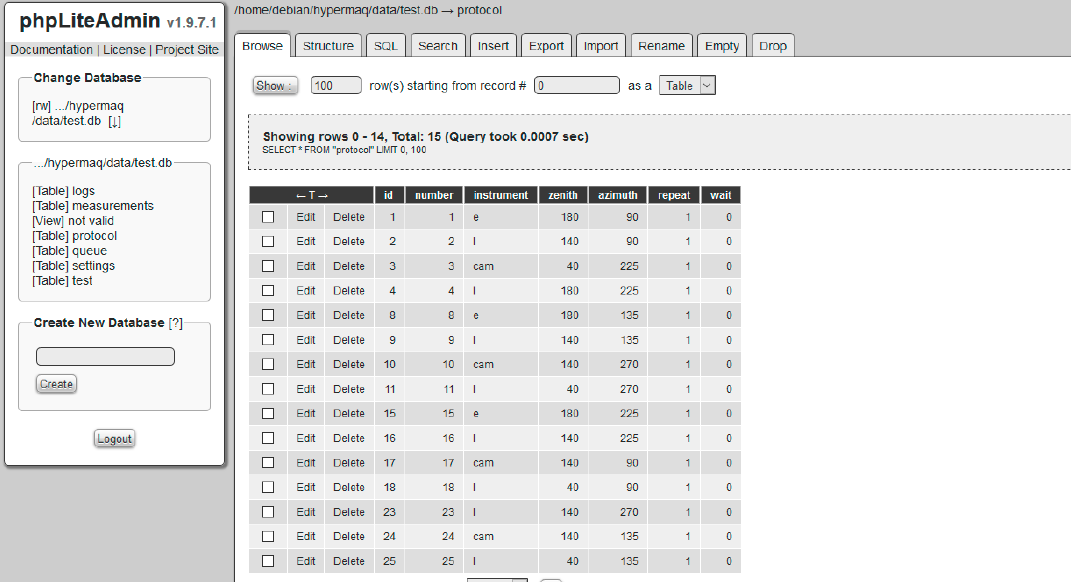
Figure 3. Screenshot of SQLite database interface.